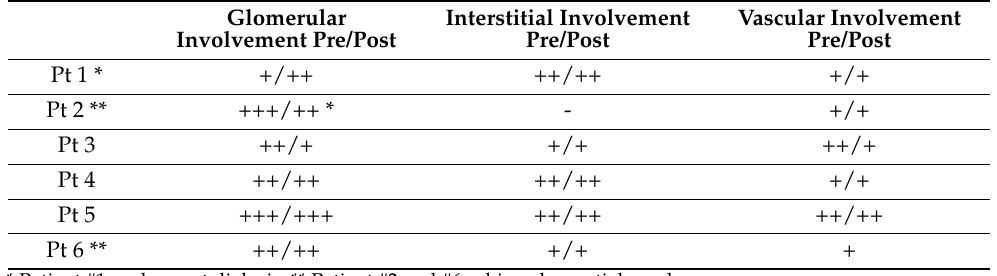
Table 2. Distribution of amyloid deposits in the kidney before and after treatment with daratumumab. Glomerular Interstitial Involvement Vascular Involvement Involvement Pre/Post Pre/Post Pre/Post